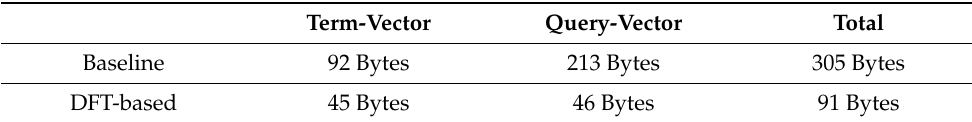
Table 7. Memory consumption per query in bytes required to store the descriptors of the term-vectors and the